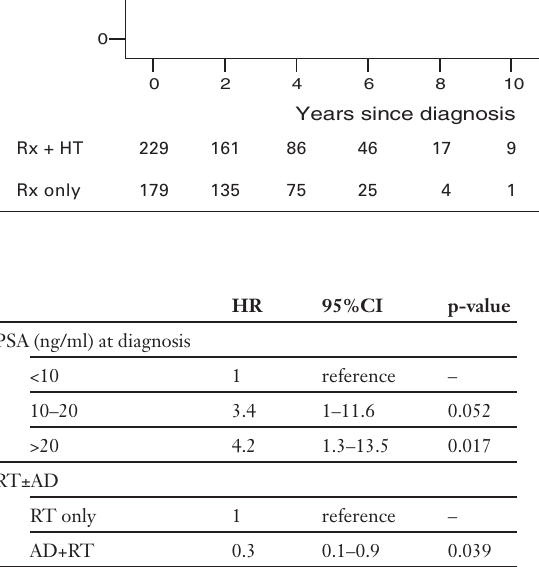
Biochemical disease- free survival (Kaplan- Meier, log-rank test) for the 229 patients treated by radiother- apy alone (Rx only) and for the 179 pa- tients treated by neoadjuvant and con- comitant androgen deprivation plus ra- diotherapy (Rx and Hormones). Patients at risk at the start of each two-year period are also given.